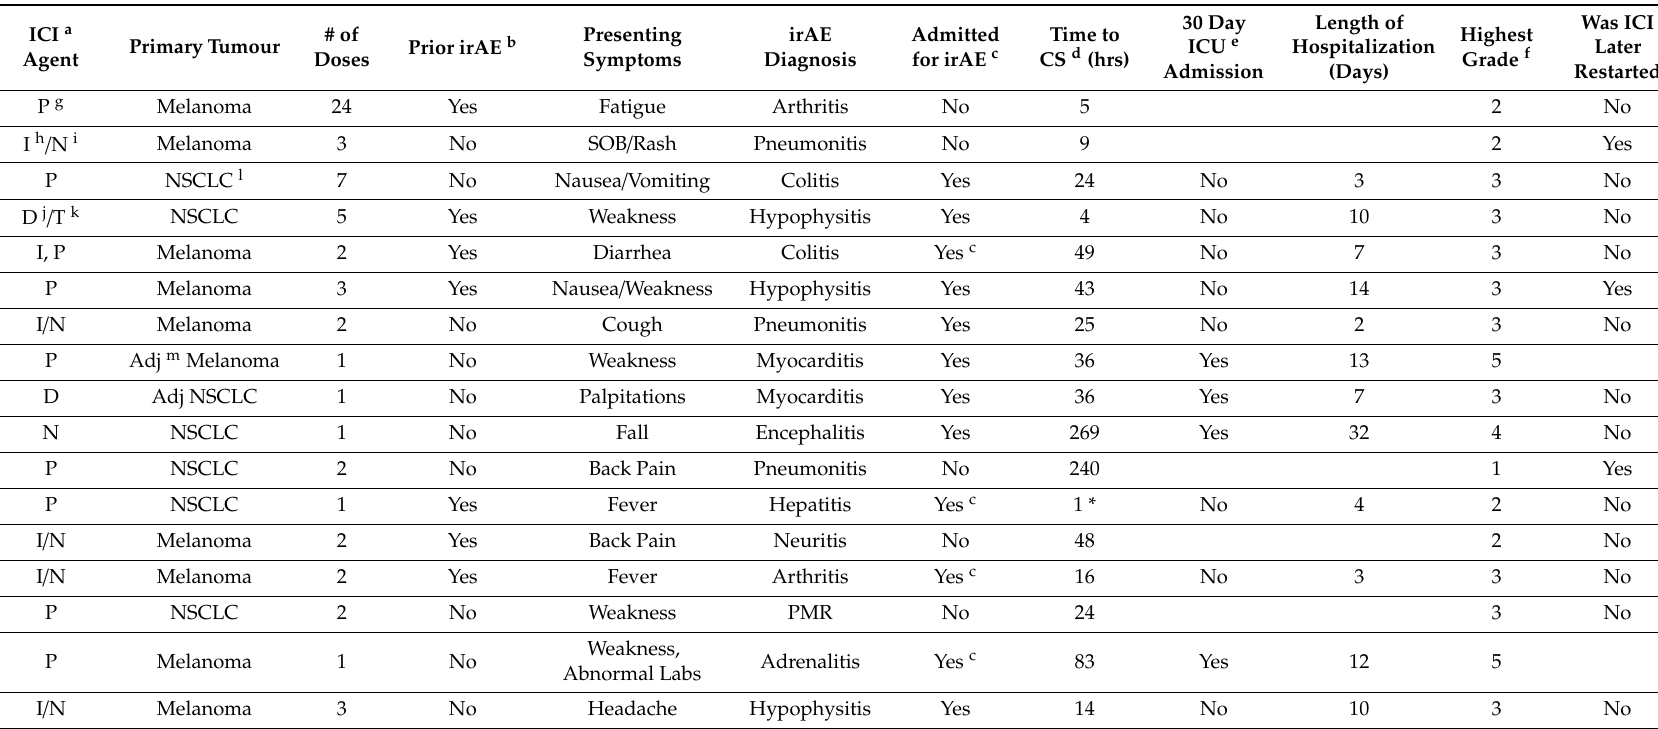
Table 2. Characteristics of treatment and toxicity in patients who had first presentation of an immune-related adverse event at the emergency department. ICI